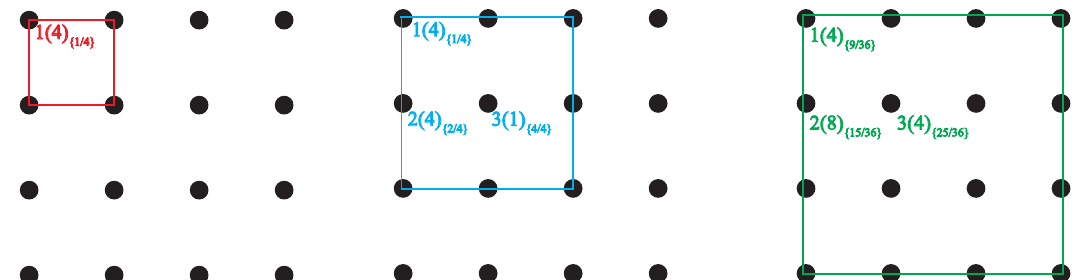
Figure 4. Numbering scheme for all possible origins of SAWs restricted to a tube of square cross section on the cubic P (simple cubic, SC) lattice, for three tube cross section sizes. In all panels, black circles represent lattice points, squares are the tube cross sections: 1 × 1, 2 × 2 and 3 × 3 from left to right. The view is along the tube axis in direction [ 100 ] . Numbers on the left correspond to the label of each distinct origin ( type ). Numbers in parentheses correspond to the cardinality (multiplicity) of each subset. Subindices in braces correspond to area ratios (overlaps), r i .